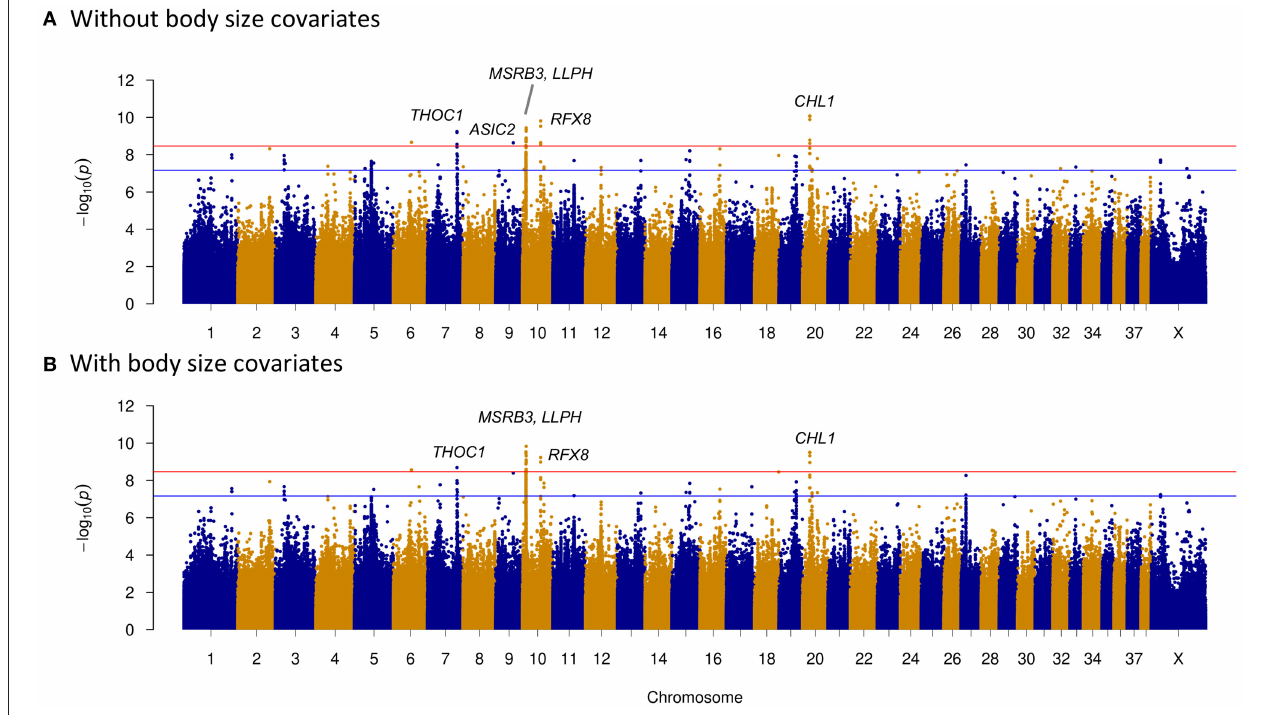
FIGURE 2 | Manhattan plots of herding behavior genome-wide association study (GWAS). The plots show the –log10 p -values for all variants of GWAS. Red horizontal line represents the Bonferroni genome-wide significance threshold, and blue horizontal line indicates suggestive significance threshold. (A) Without including body size as a covariate. Candidate genes around significantly associated sites (above the Bonferroni threshold) were marked with red color in the Manhattan plot; they are THOC1 of CFA7; ASIC2 of CFA9; MSRB3 , LLPH , and RFX8 of CFA10; and CHL1 of CFA20. (B) Including body size as a covariate. Candidate genes ( THOC1 , MSRB3 , LLPH , RFX8 , and CHL1 ) were marked in the